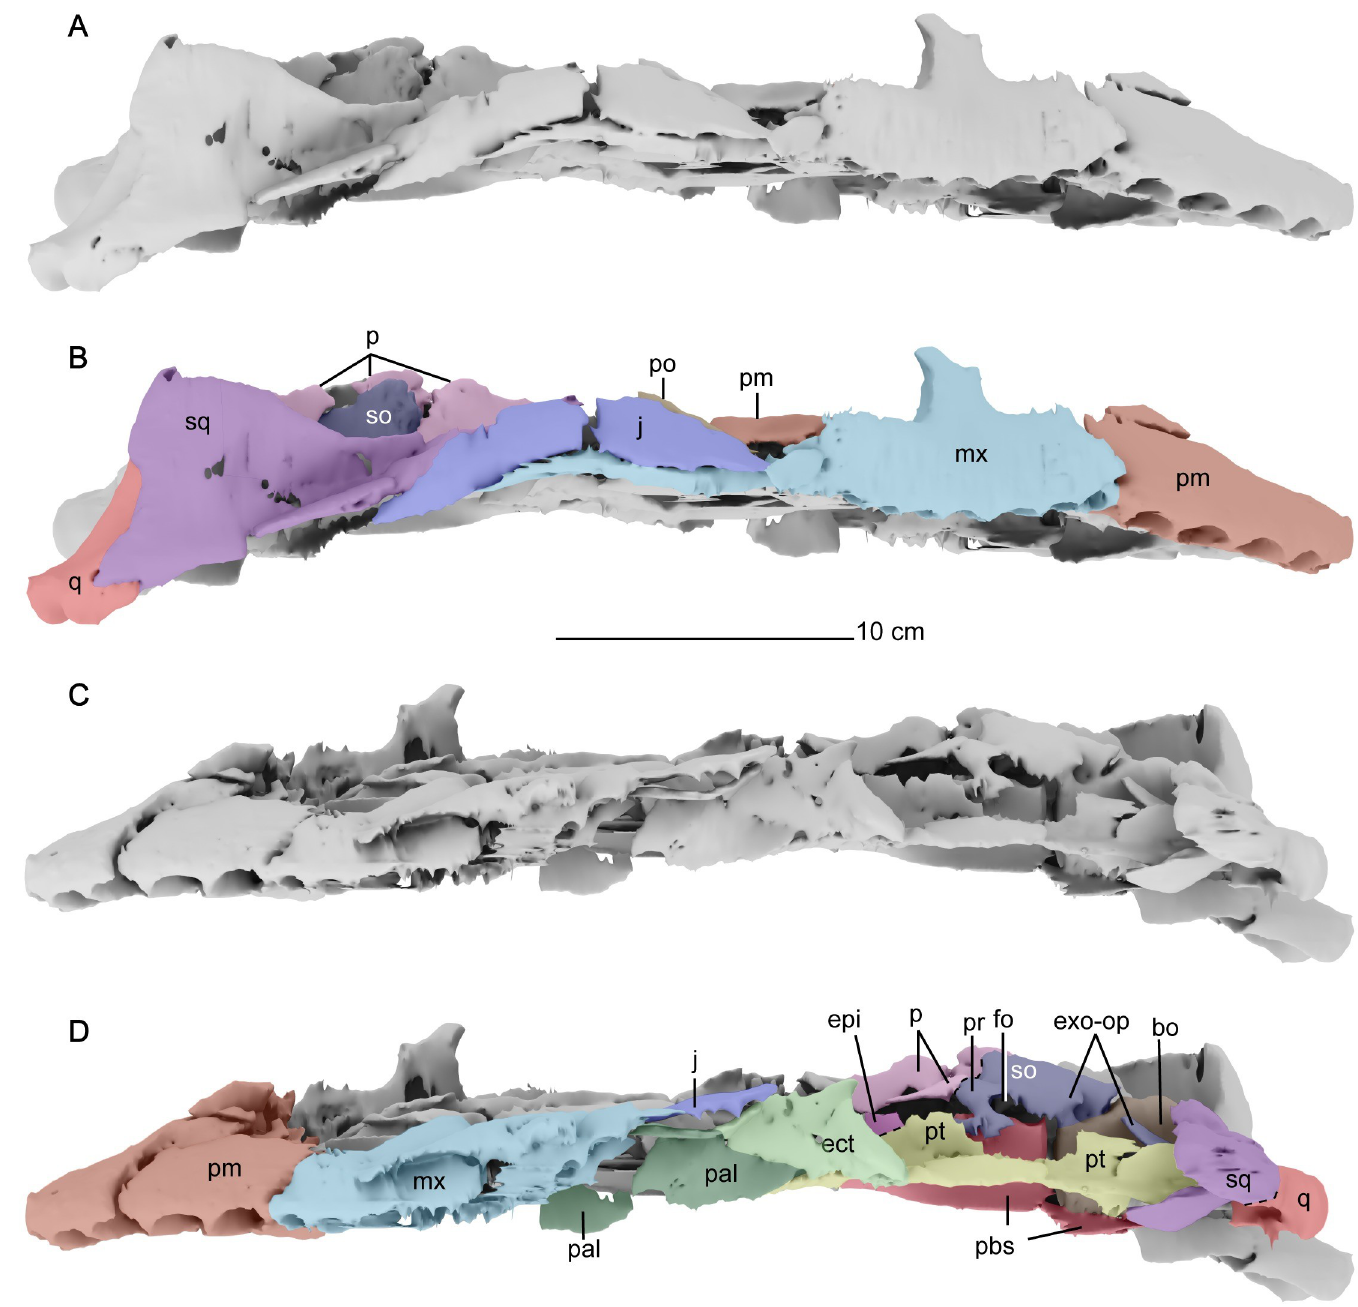
Fig 7. Lateral views of the cranium of Cardiocorax mukulu (MGUAN PA278). A-B. right lateral view. C-D. left lateral view. Dashed lines indicate approximate sutural contacts. https://doi.org/10.1371/journal.pone.0255773.g007 Jugal . The jugal is an elongated element that contributes to the posteroventral margin of the orbit, bordered ventrally by the maxilla and dorsally by the postorbital. The postorbital restricts the jugal from the dorsal margin of the temporal bar. The suture between the jugal and the squa- mosal forms a sharp interdigitating pattern and is inclined anterodorsally-posteroventrally (Fig